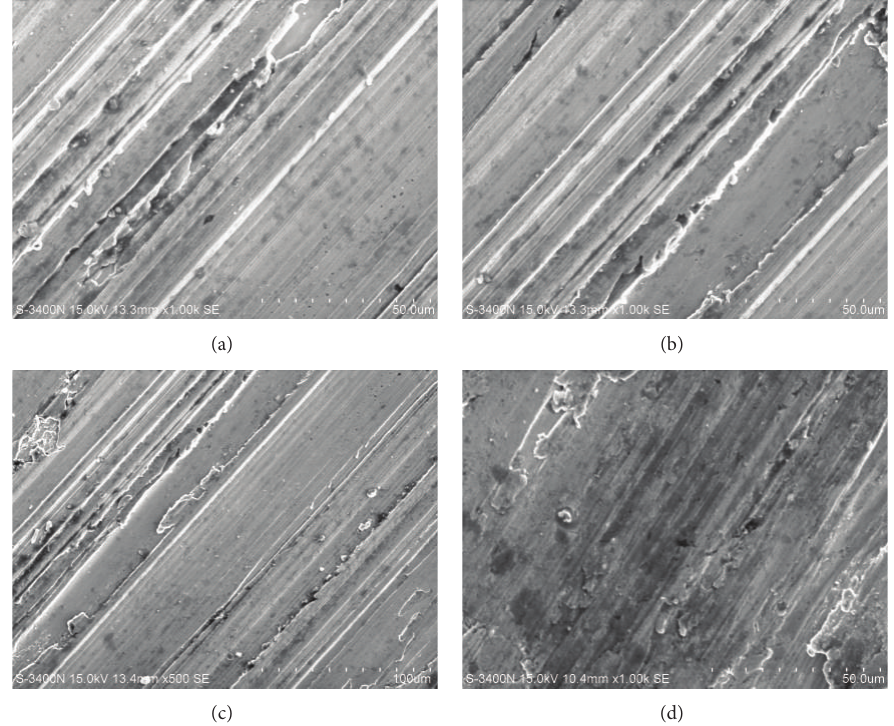
Figure 18: SEM micrograph (1000 × ) of wear track for coated magnesium (Mg) composite reinforced with multiwall carbon nanotube (MWCNT) at various SiO (a) 0.1% (b) 0.5% (c) 1% (d)